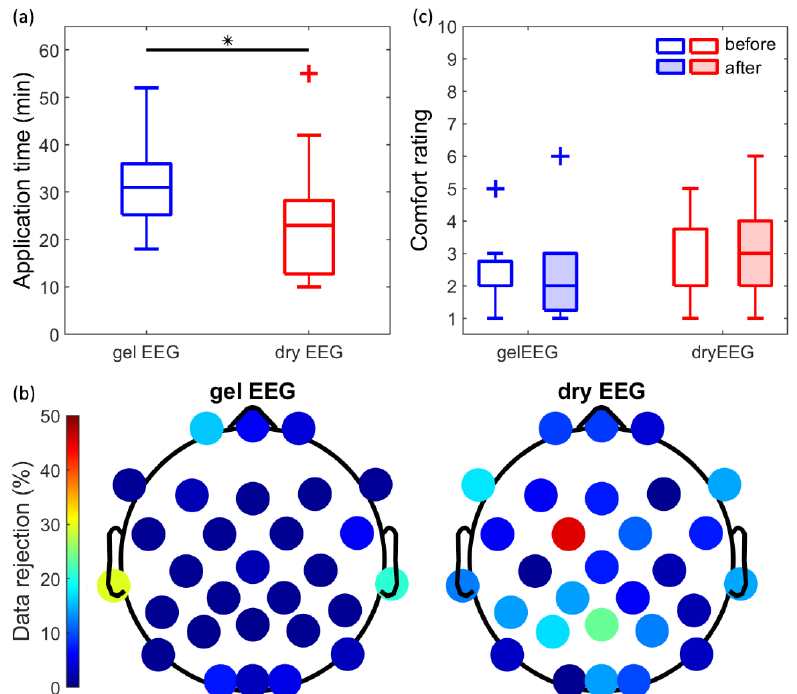
Figure 6. General performance. ( a ) Application time (min) for the gel EEG system (blue) and the dry EEG system (red). ( b ) Percentage of data rejection (%) per channel averaged over subjects for the gel EEG system (left) and the dry EEG system (right). 0% = no data rejected; 100% = all data rejected. Color bar from 0–50%. ( c ) Experienced comfort for the gel EEG system (blue) and the dry EEG system (red), rated by the subject before (open) and after the experiment (shaded). 1 = extremely comfortable; 10 = maximum imaginable pain. * p < 0.01.